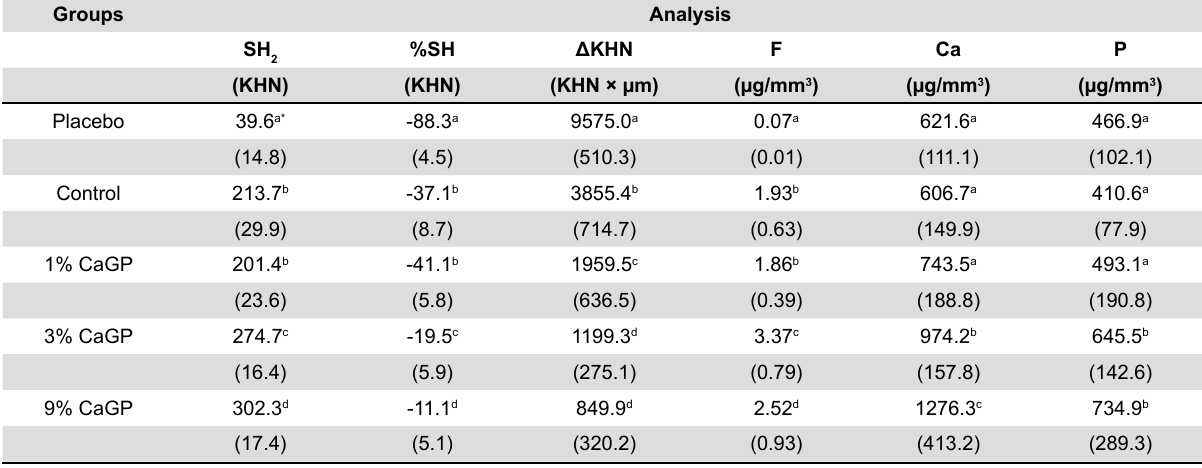
Table 2- Mean values (SD) of the final surface hardness (SH hardness (ΔKHN), fluoride (F), calcium (Ca) and phosphate (P) from enamel according to the groups (n=12)